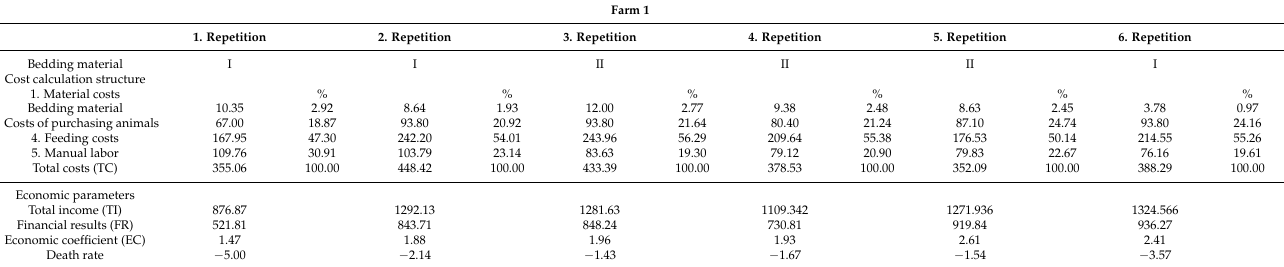
Table 6. Calculated economic results for Farm 1.